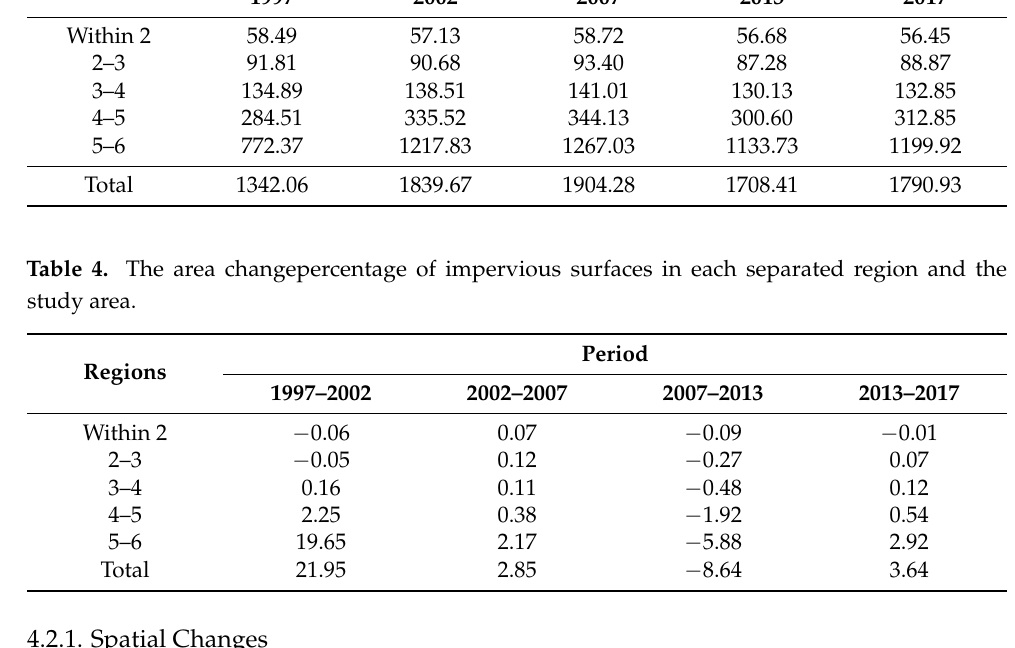
Table 3. The impervious surface area (ISA) in each separated region and the study area (unit: km 2 ). Regions